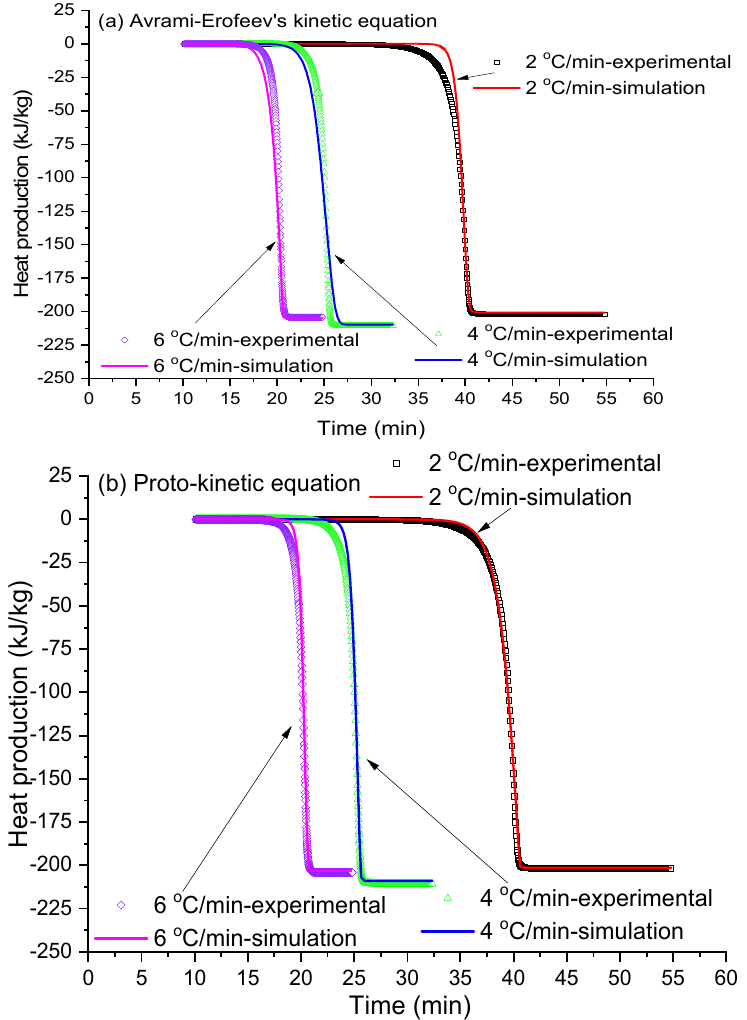
Figure 5. Selected fresh TF ice cream heat production versus time curves with DSC various heating rates of 2, 4, and 6 °C/min by comparing ( a ) Avrami-Erofeev’s kinetic and ( b ) Proto-kinetic model simulation.